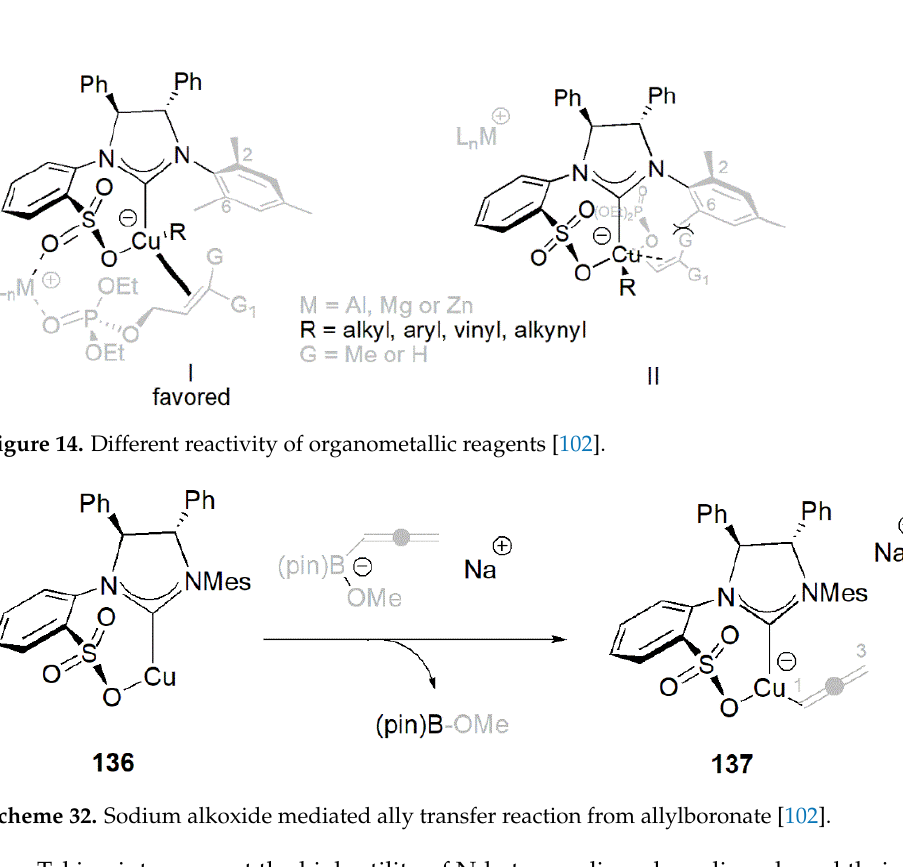
26 of 73 Figure 13. Dimeric silver complexes with NHC ‐ sulfonate donors [90]. Hoveyda et al. reported another novel catalytic enantioselective allylic substitution reaction using analogous bidentate NHC ‐ sulfonate ligands. In this case, allenylboronic acid pinacol ester addition to allylic phosphates could potentially lead to allenyl containing products or to a propargyl addition to allylic substrate (Scheme 31). The catalyst introduced by this group, a sulfonate ‐ bearing chiral bidentate NHC ‐ Cu complex, favored the production of allenyl containing products in almost quantitative yields with enantiomeric ratio of 95.5:4.5. [102]. Scheme 31. Allenylboronic acid pinacol ester addition to alkenes [102]. In enantioselective allylic substitution reactions, apart from copper salt and phosphine or NHC based ligands, organometallic (L n M in Figure 14) or boron ‐ based reagents are used as co ‐ catalysts [102]. Organometallic reagents, L n M, are Lewis acids and